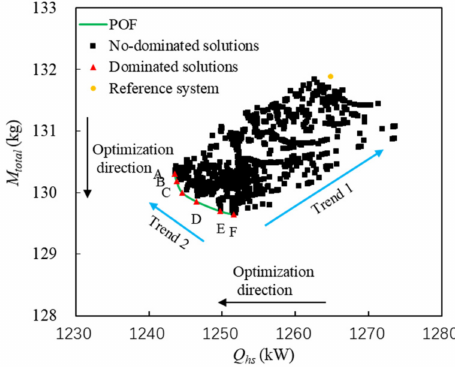
Figure 10. System-level optimization